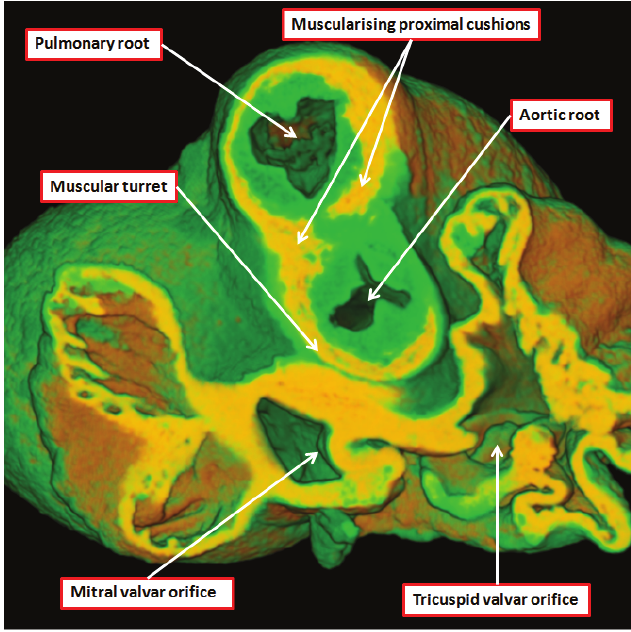
Figure 13. The image, from an episcopic dataset, is a short axis section across the cardiac base of an embryonic mouse at E13.5, viewed from the atrial aspect. The mouse was genetically modified to show the location of the myocardial components, which are colored yellow. At this stage, the developing valvar components are contained within a myocardial turret. New myocardium, however, is entering the proximal outflow cushions, and will eventually form the free-standing infundibular sleeve of the right